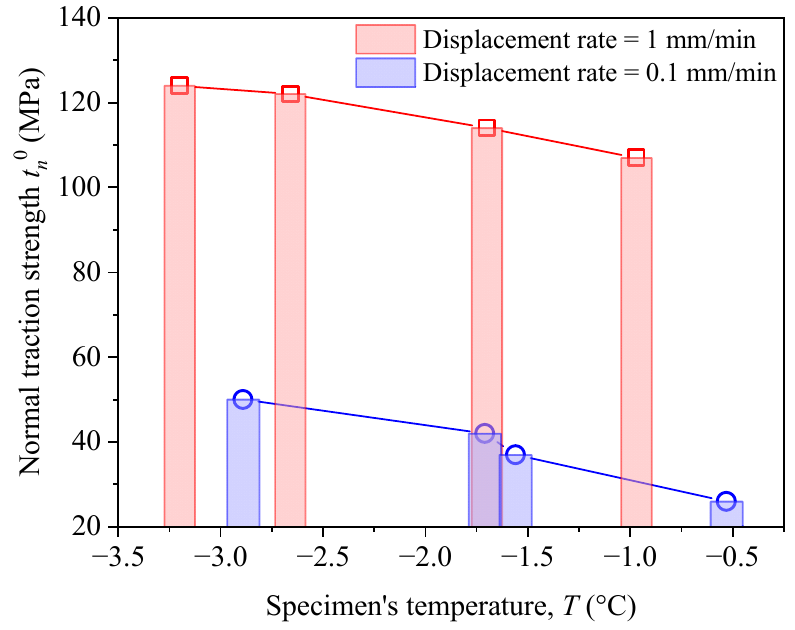
C G with specimen I C G I